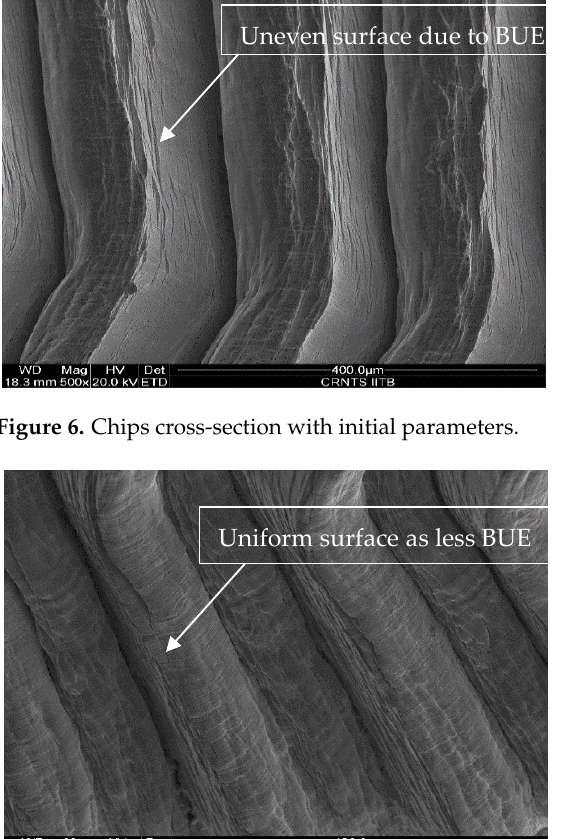
Figure 7. Chips cross-section by using proposed optimized parameters.